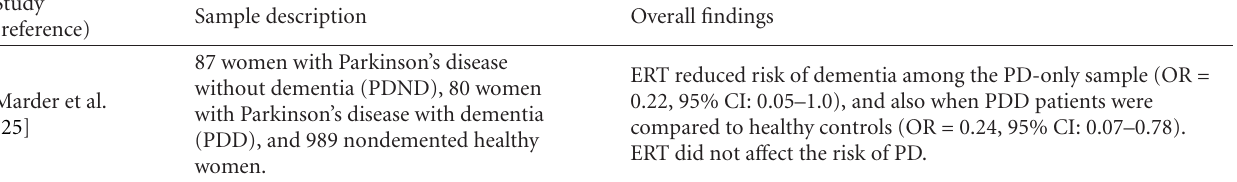
Table 3: Case-control and epidemiological studies of HRT and Parkinson’s